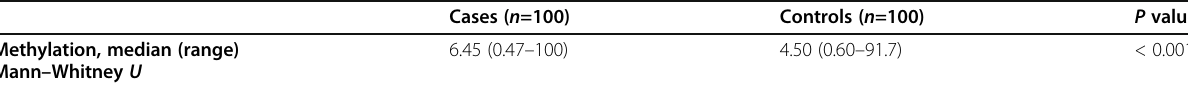
Table 2 Methylation among cases of pregnancy loss compared to controls